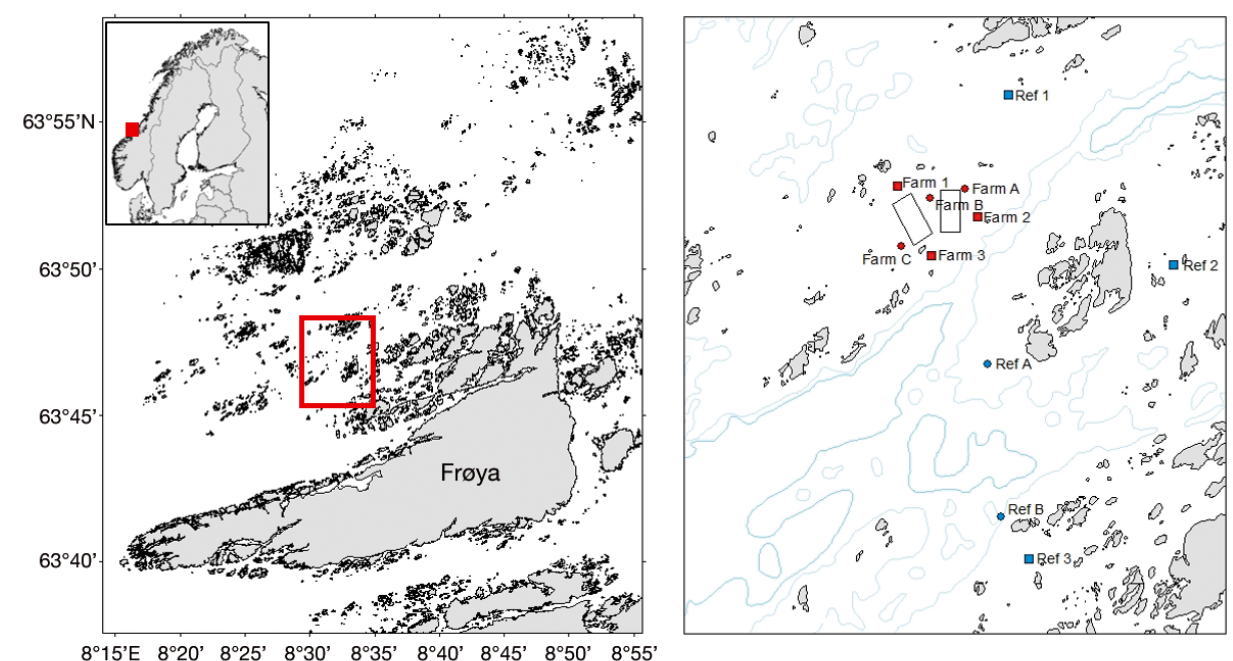
Fig. 1. Sampling locations. Left: archipelago area north of Frøya, Norway (inset). Right: sampling area with black rectangles indicating the general Rataren farming locations. Red symbols: sampling within the farm area; blue symbols: reference (Ref) locations. Squares: SCUBA sites for scallop and sediment samples; circles: seston trap placements. Depth contours are at 100 m (light blue) and 200 m (darker